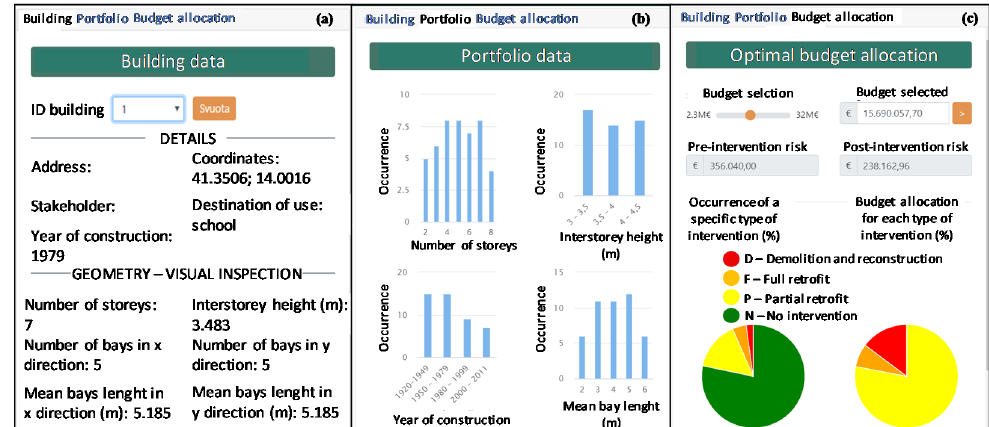
Figure 7. Information portal: ( a ) building’s registration data; ( b ) portfolio main characteristics; ( c ) interactive budget allocation.